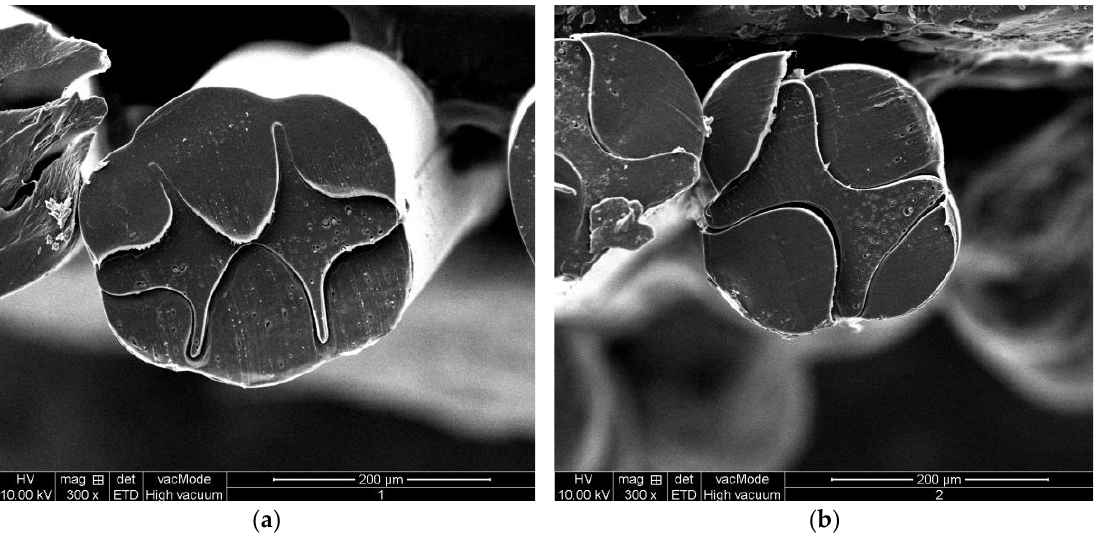
Figure 12. SEM image of the fiber cross-section. ( a ) “Fishbone” pattern; ( b ) “H-shaped” pattern.